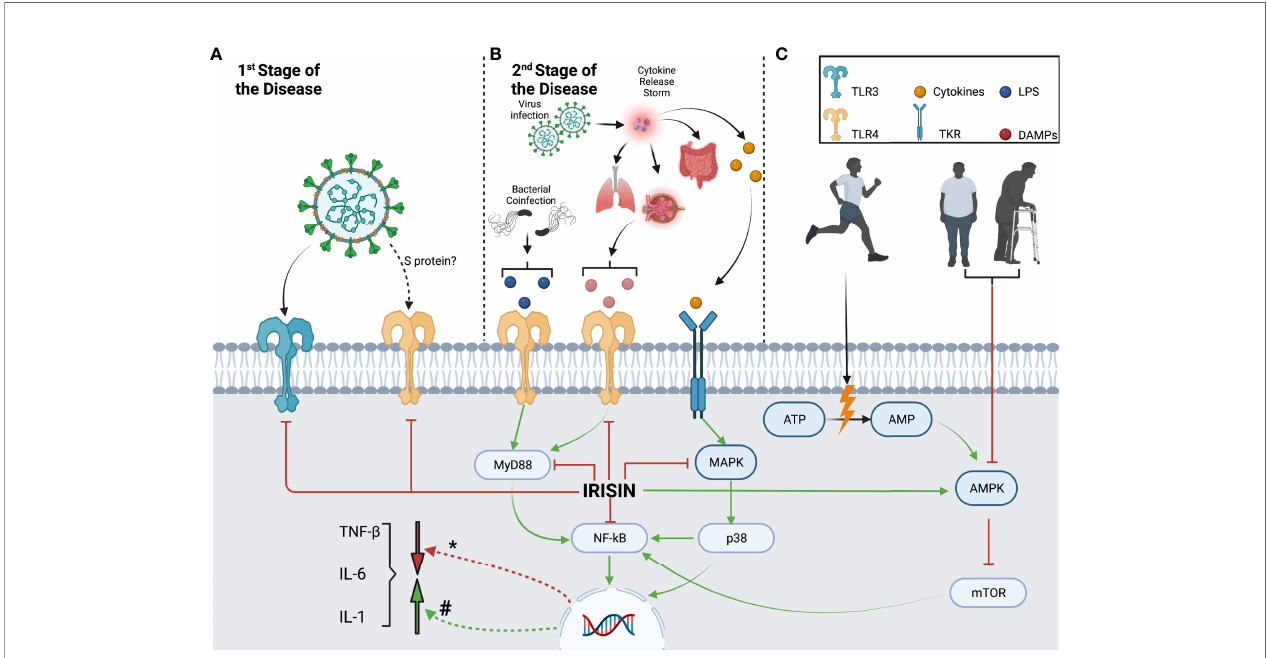
FIGURE 1 | Macrophage in fl ammatory pathways modulated by irisin during different SARS-CoV2 infection stages and lifestyle contexts. (A) The fi rst stage of SARS-CoV2 infection activates innate immune responses through the recognition of PAMPs by TLR3 and TLR4, which are downregulated by irisin. (B) The second stage of SARS-CoV2 infection causes cellular damage and induces a cytokine release storm, which activates the MAPK/p38/NF-kB pathway through TKR. CRS results in further organ damage, leading to DAMP release and MyD88/NF-kB pathway activation. Irisin can downregulate both these pathways, decreasing in fl ammatory cytokine production. In addition, the TLR4 and MyD88/NF-kB pathways can be stimulated by LPS, which can be released due to potential bacterial coinfection. (C) Although sedentarism and aging lead to AMPK downregulation and consequent mTOR activation, exercise produces the opposite effect. Exercise-derived AMP and irisin can stimulate AMPK, inhibiting mTOR and downregulating the NF-kB pathway while decreasing cytokine production (#) Cytokine transcription modulation by in fl ammatory pathways. (*) Cytokine transcription modulation by